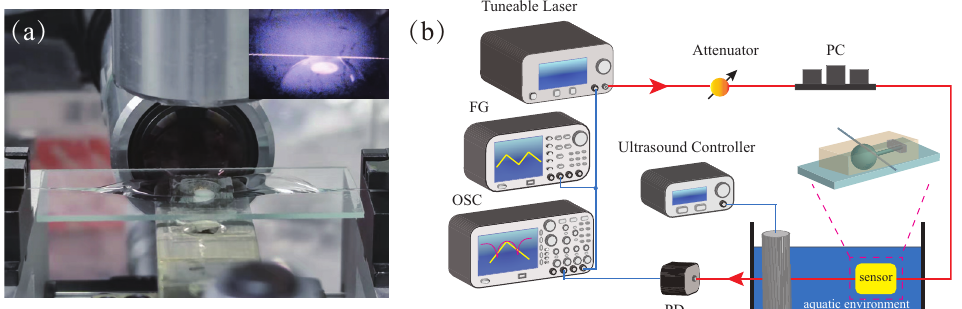
Figure 1. ( a ) Photograph showing the microsphere after encapsulation. Inset: incompletely packaged microsphere. ( b ) Experimental scheme of the ultrasound detection. PC, polarization controller; PD, photodetector; OSC, oscilloscope; FG, function